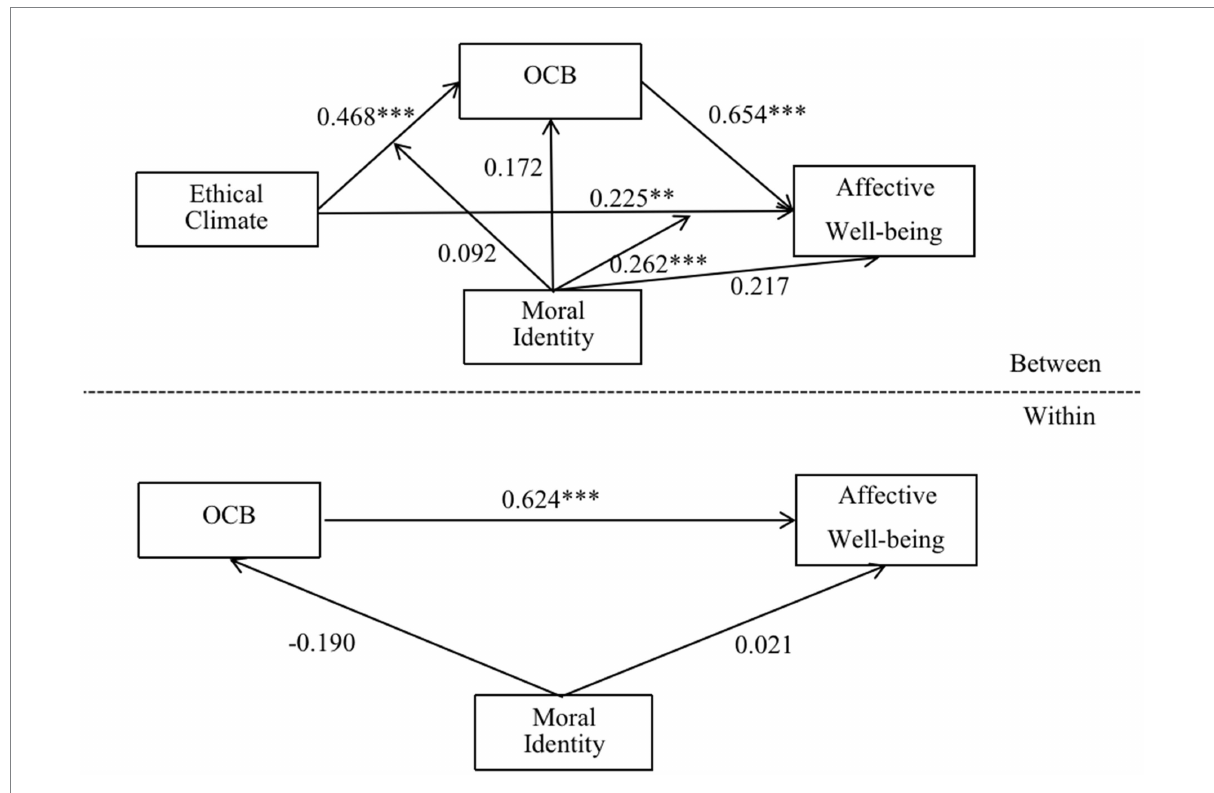
FIGURE 4 Robustness test: multi-level structural equation modeling (MSEM). *** p <0.001; ** p